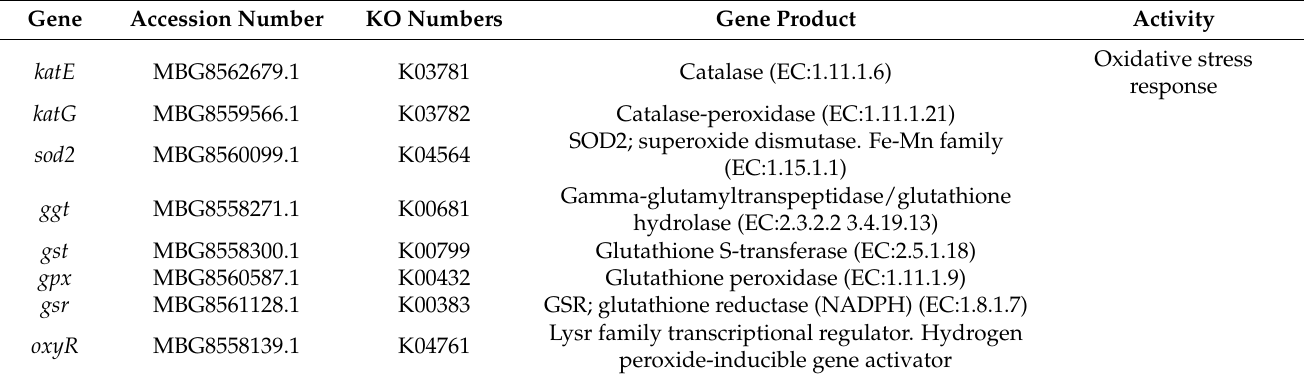
Table 7. Genes potentially involved in response to oxidative stress in the ZCR6